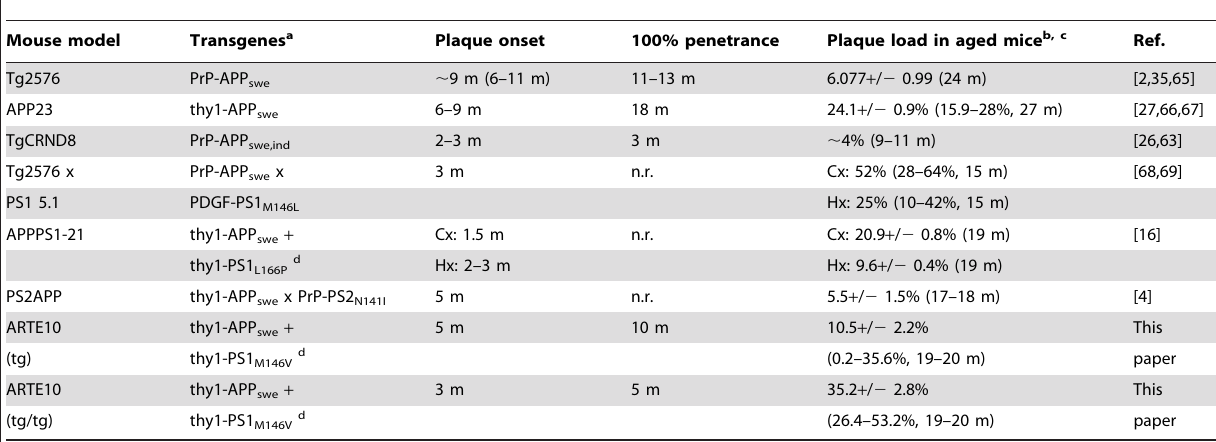
Table 1. Comparison of amyloid burden in transgenic mouse models of AD.